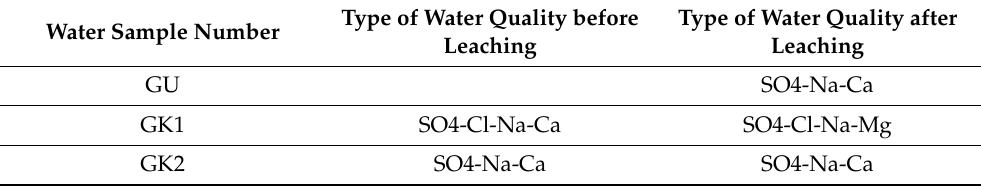
Figure 7. Piper three-line diagram of mine water before and after leaching. Table 2. Type of mine water quality before and after